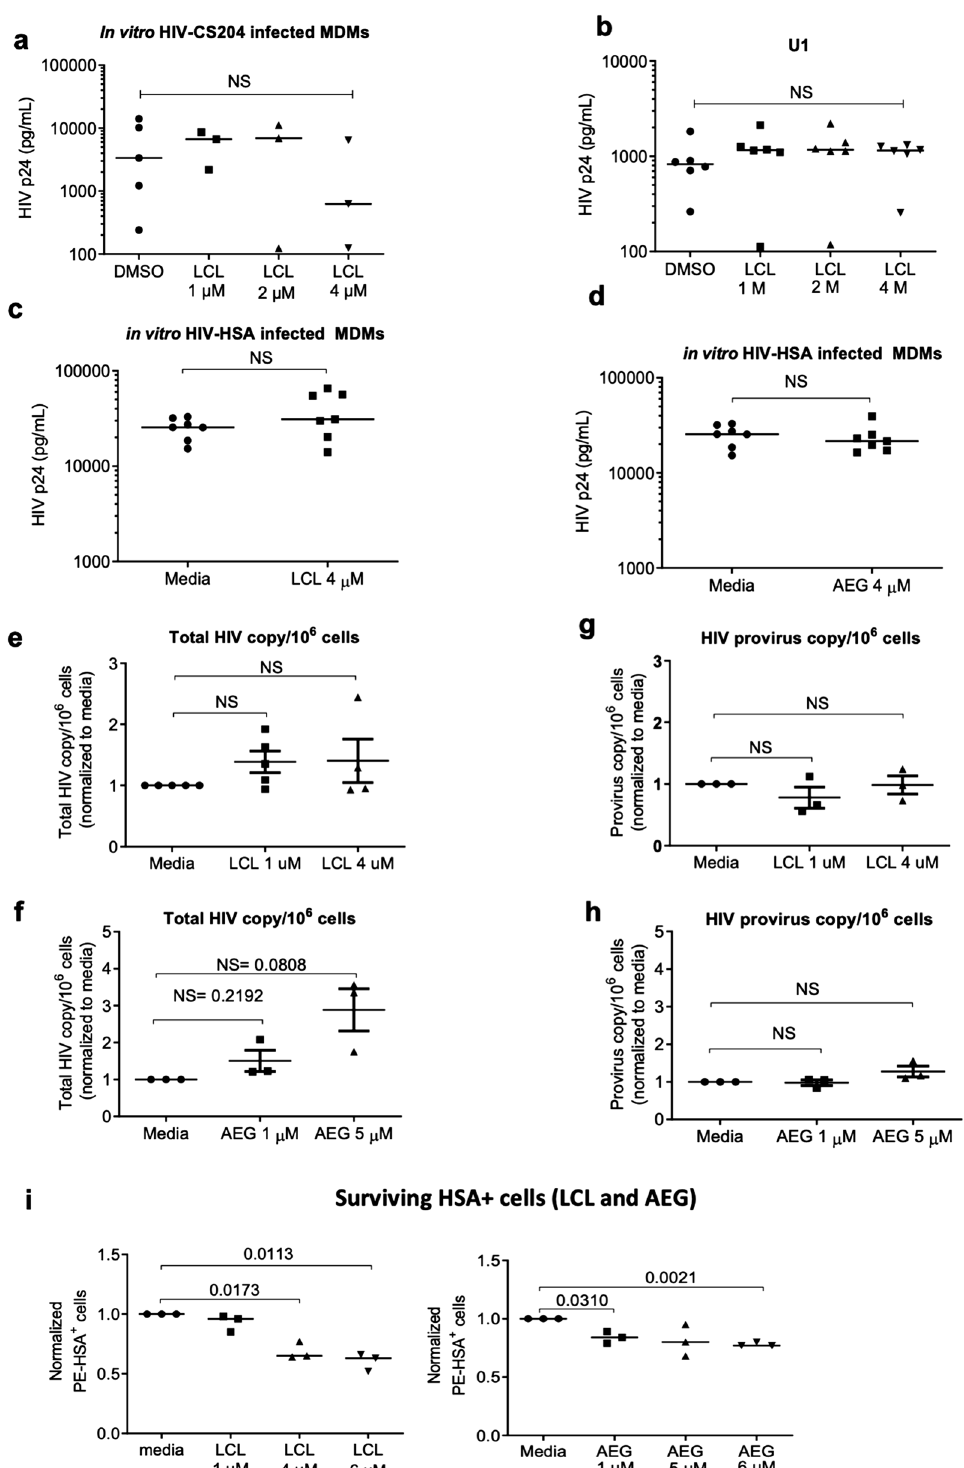
Figure 5. SMs do not affect HIV replication in HIV-infected macrophages. ( a ) In vitro HIV-1 CS204 infected MDMs (n = 5) and ( b ) undifferentiated U1 (tn = 6) cells were treated with increasing dose of LCL161. After 48 h, supernatants were quantified for p24 by ELISA. In vitro HIV-HSA infected MDMs were treated with LCL161 (n = 7) ( c ) and AEG40730 (n = 7) ( d ) for 4 d and p24 in the supernatants was analyzed by ELISA. MDMs were infected in vitro with HIV-1 CS204 for 7 d were treated with LCL161 and AEG40730. Whole cell lysates were analyzed for Total HIV-DNA ( e and f , n = 5) and integrated proviral HIV-DNA ( g and h , n = 3) using ultra sensitive qRT-PCR. ( i ) HIV-HSA infected MDMs were treated with LCL161 and AEG40730 for 7 days. Dead cells were thoroughly removed from the culture well by washing with DPBS. Surviving adherent cells were collected and were analyzed for HIV-HSA infection by anti-HSA staining and flow cytometry (n = 3). The p -values were calculated using two-tailed Mann–Whitney U test. (NS: no